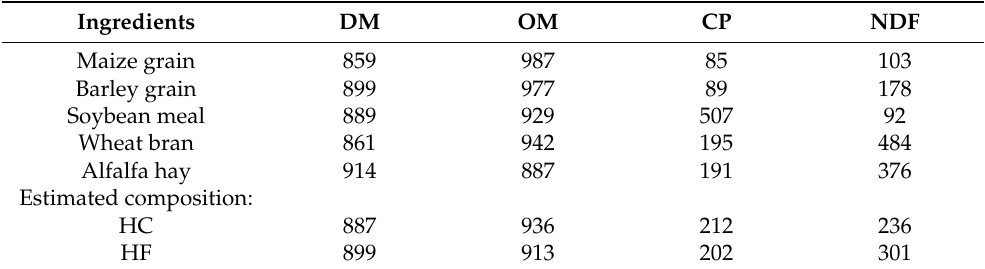
Table 1. Chemical composition (g/kg dry matter) of ingredients and estimated composition of incubated substrates (high-concentrate, HC; high-forage,